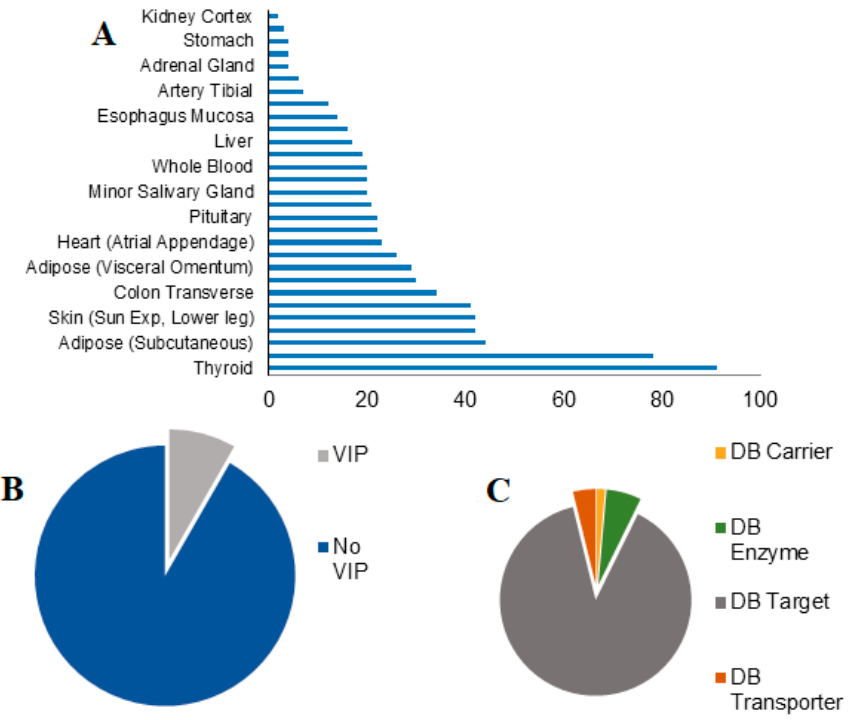
Figure 1. Sex-differential gene expression in pharmacogenes. ( A ) The number of sex-biased drug response genes (SBDR) identified per tissue (FDR < 0.05) are indicated. ( B ) Proportions of VIP and no VIP genes identified according to the PharmGKB classification. ( C ) Proportions of drug target, transporter, carrier, and enzymes identified according to DrugBank classification.